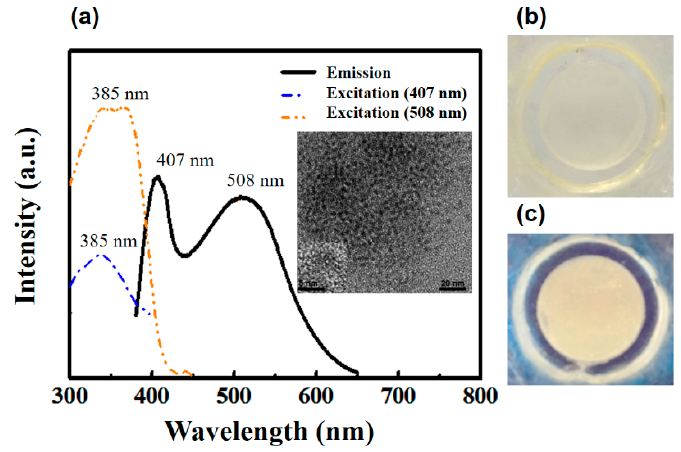
Figure 2. ( a ) Excitation and emission spectra of WQDs. The inset in ( a ) is the TEM image of WQDs. The photographs of liquid-type WQD in the glass package for ( b ) before UV LED pumping and ( c ) after UV LED pumping.